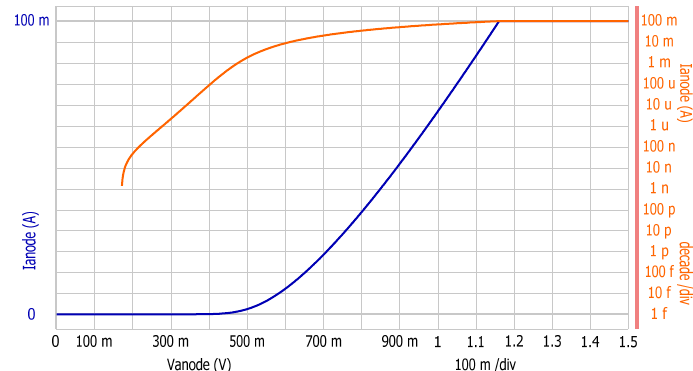
Figure 6. The forward I-V characteristic curve test results of the 2CZ106C.